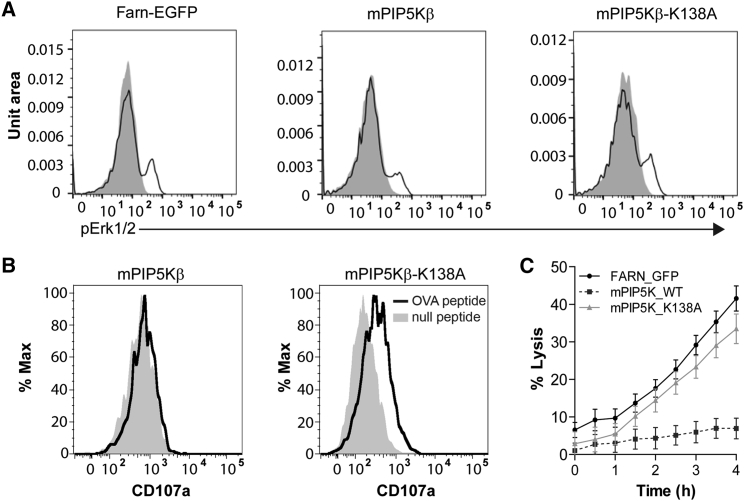
TCR Activation Fails to Induce Degranulation and Target Cell Killing(A) pERK activation of CTLs expressing mPIP5Kβ, mPIP5Kβ-K138A, or farnesyl-EGFP stimulated with plate-bound anti CD3 (black line) or unstimulated (shaded peaks) (n = 3 independent experiments).(B) Degranulation assay measured by CD107a uptake of CTLs expressing either mPIP5Kβ or mPIP5Kβ-K138A in response to targets pulsed with either OVA (bold line) or the null-peptide (NP68) (gray shaded peaks) after 2.5 hr (n = 4 independent experiments).(C) Percentage target cell lysis of NucRed-EL4 over 4 hr by CTL expressing either mPIP5K (dotted-line), mPIP5Kβ-K138A (gray line) or farnesyl-EGFP (black line) (showing propagated SEM of triplicates; n = 3 independent experiments).See also Figure S4.